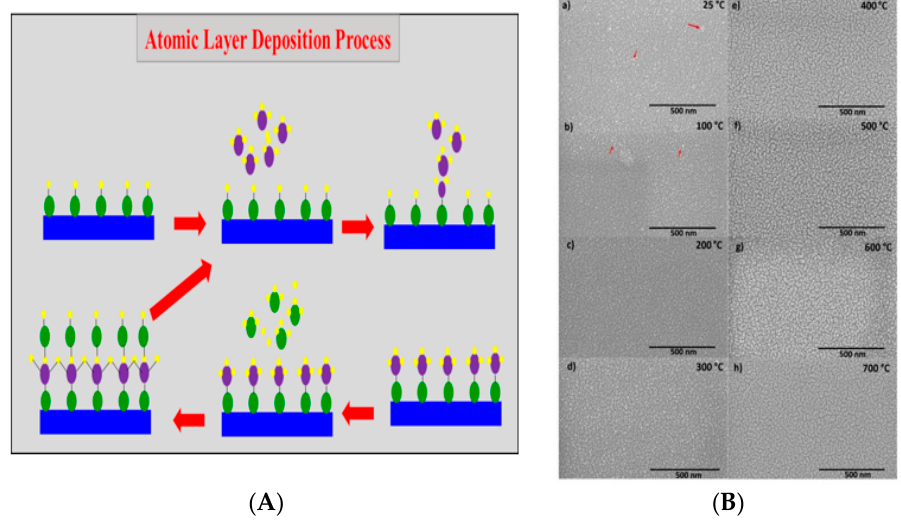
Figure 15. ( A ) Schematic representation of an atomic layer deposition (ALD) process, ( B ) top view illustrating the scanning electron microscopy (SEM) micrographs of N = niobium thin films fabricated at distinct substrate temperatures of 25–700 °C. The data illustrated are for niobium films prepared